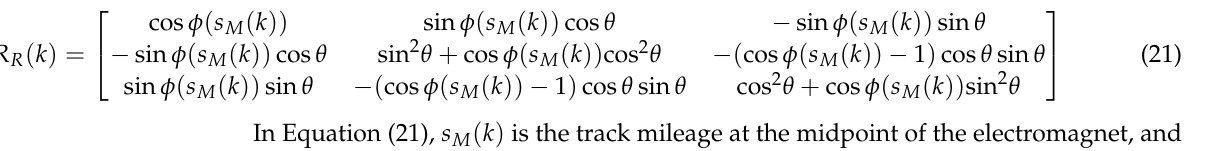
In Equation (20), s T ( i ) is the track mileage where the vehicle electromagnet coincides with the circular curve track, and there are 10 points on right track. Similarly, the pose matrix R R ( k ) of five electromagnets can be obtained: